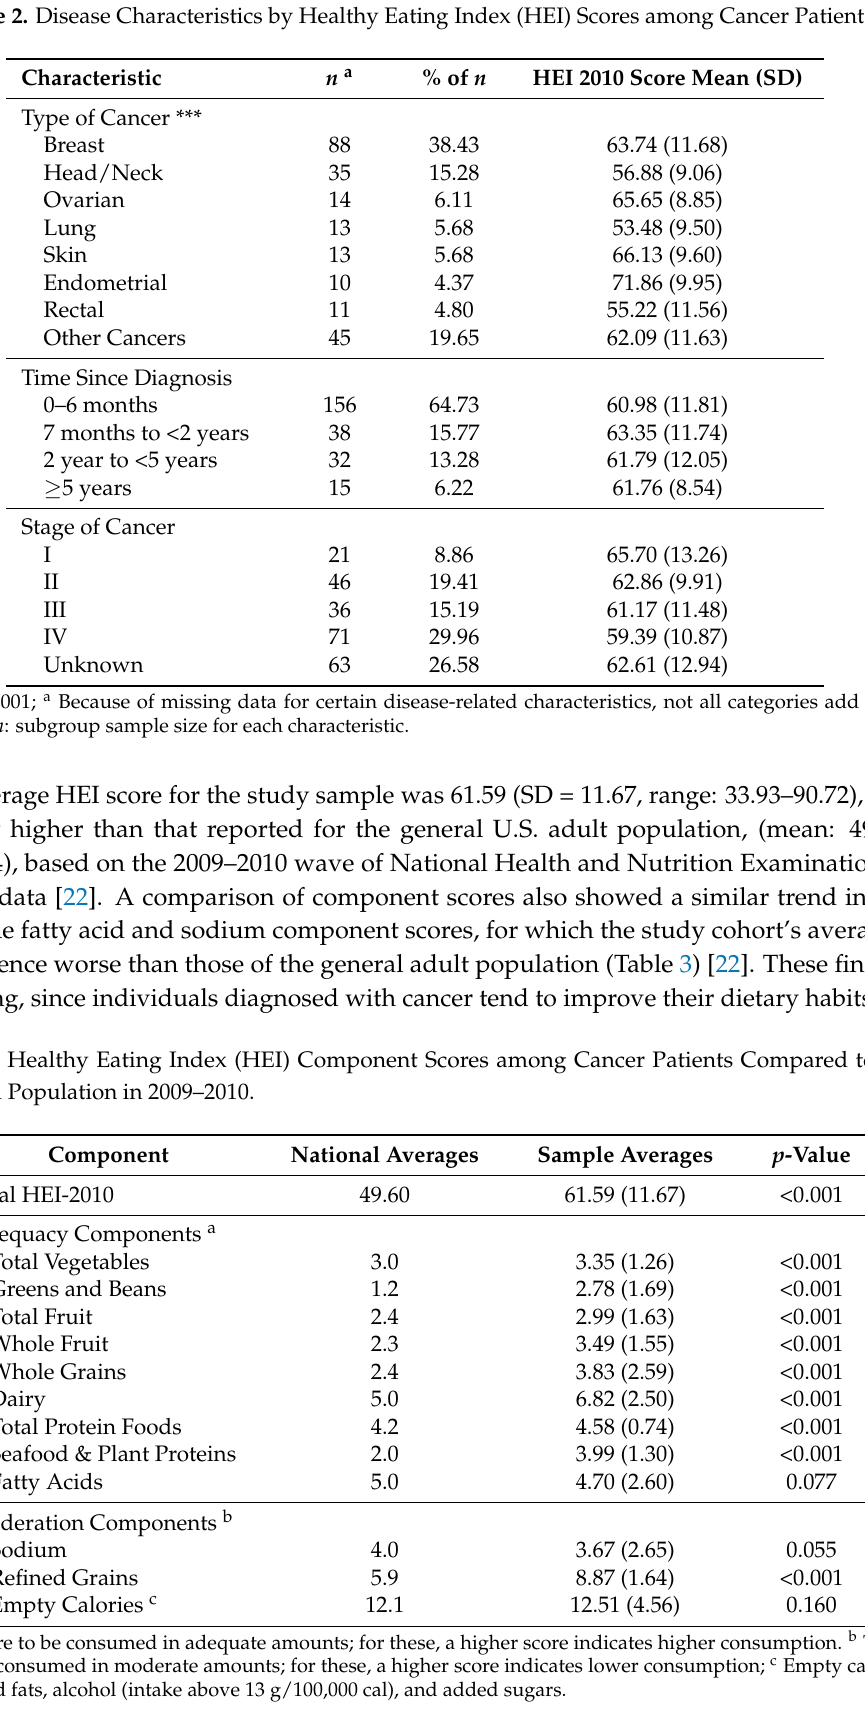
Table 2. Disease Characteristics by Healthy Eating Index (HEI) Scores among Cancer Patients.